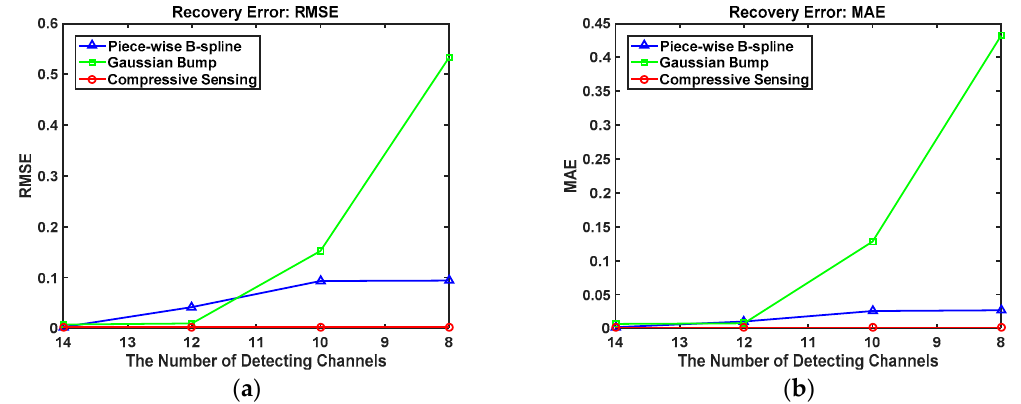
Figure 6. The Plank spectrum recovery error with three different spectrum unfolding methods as the measurements decrease. ( a ) Root mean squared error (RMSE). ( b ) Mean absolute error (MAE).